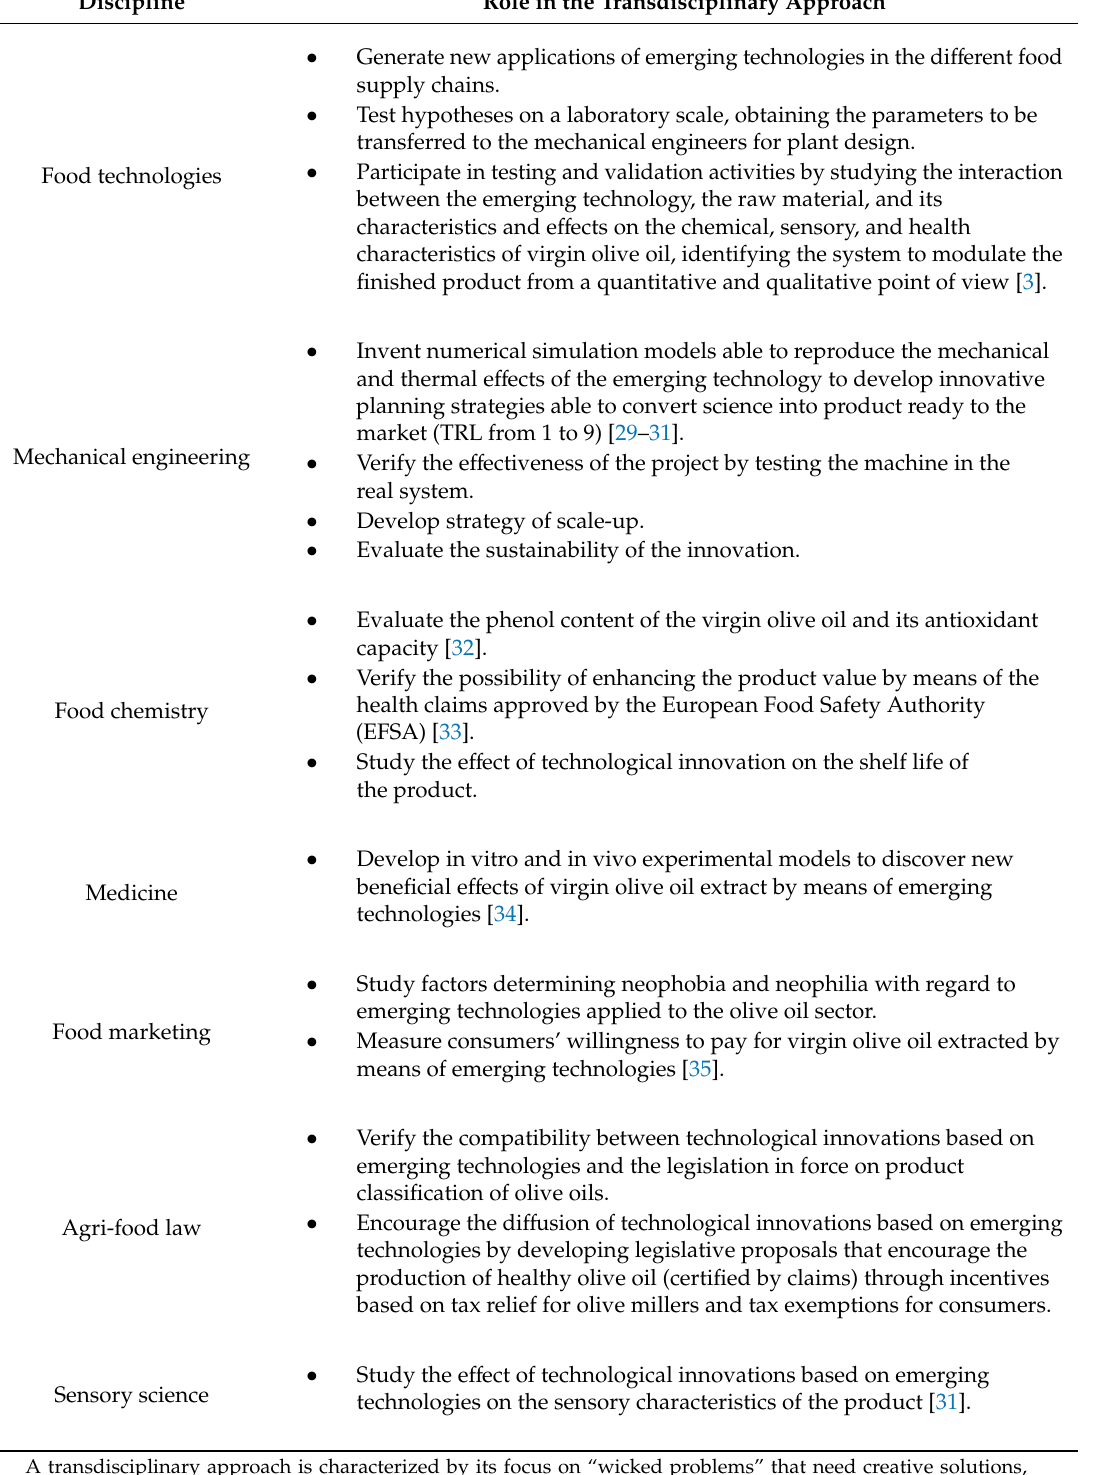
Table 1. Role of di ff erent disciplines in the trans-disciplinary approach to accelerate the development and implementation of industrial ultrasound applications in the extra-virgin olive oil extraction